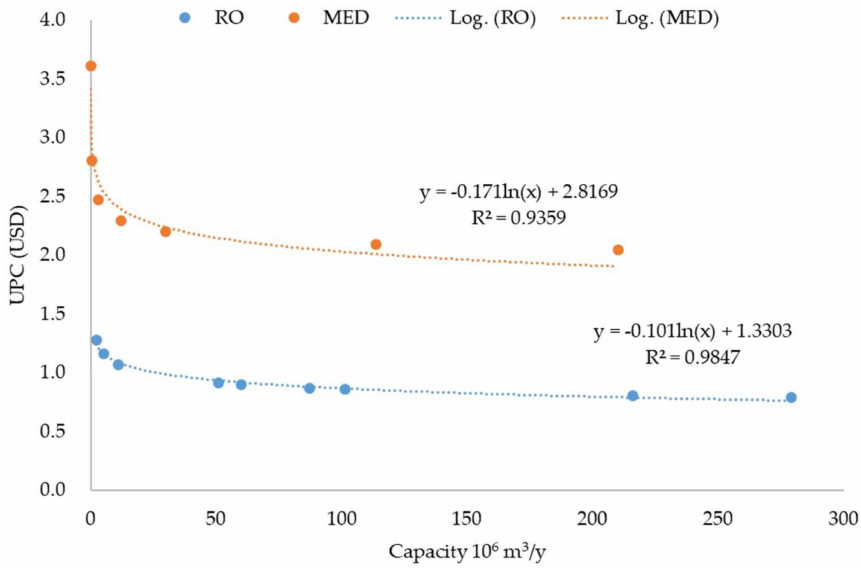
Figure 9. The correlation between unit product cost (UPC) and the seawater desalination